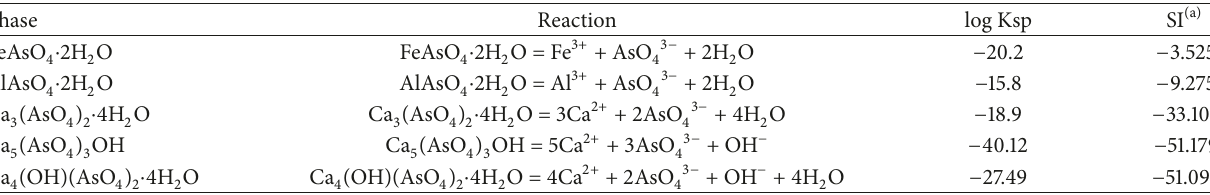
Table 4: Calculation of saturation indices (SI) for precipitation phases using the equilibrium concentrations in solution at the initial As (V) of 40 mgL −1 in the CS-Fe.